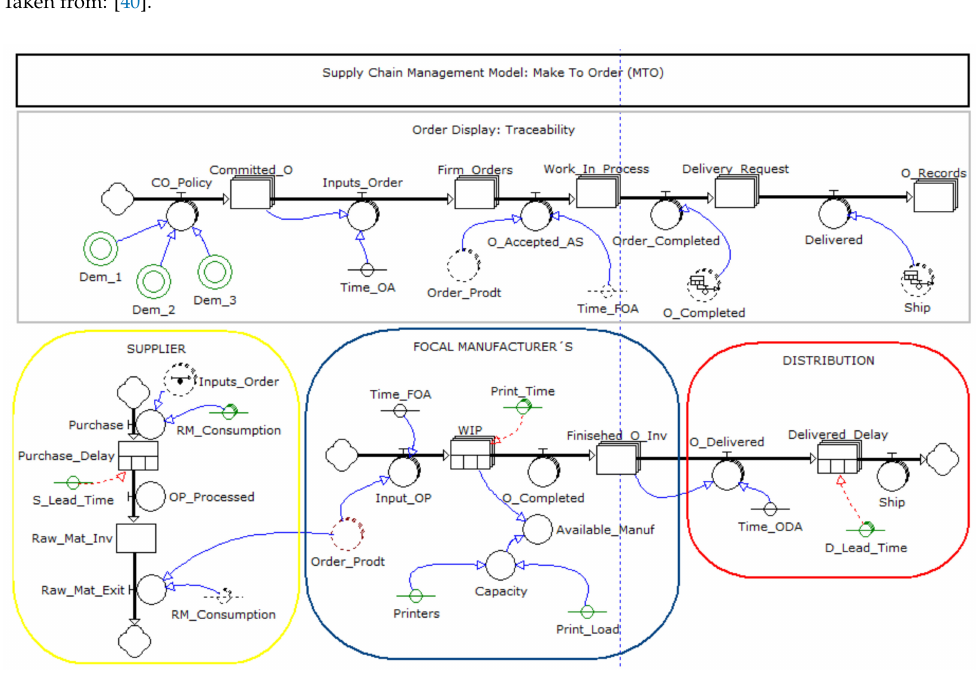
Figure 5. Data flow diagram. Order-based SCM (MTO). Source: own elaboration. Evolution